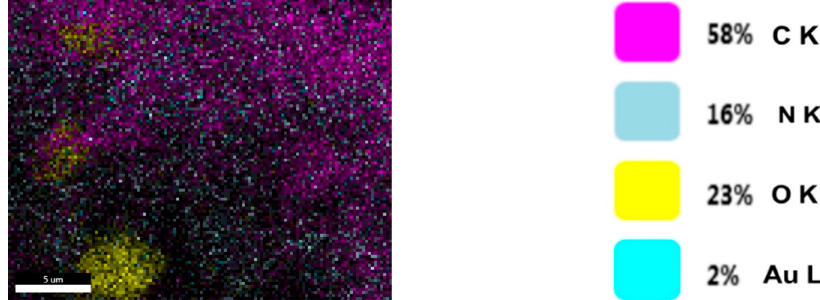
Figure 8. Viscum sample: SEM—live map.